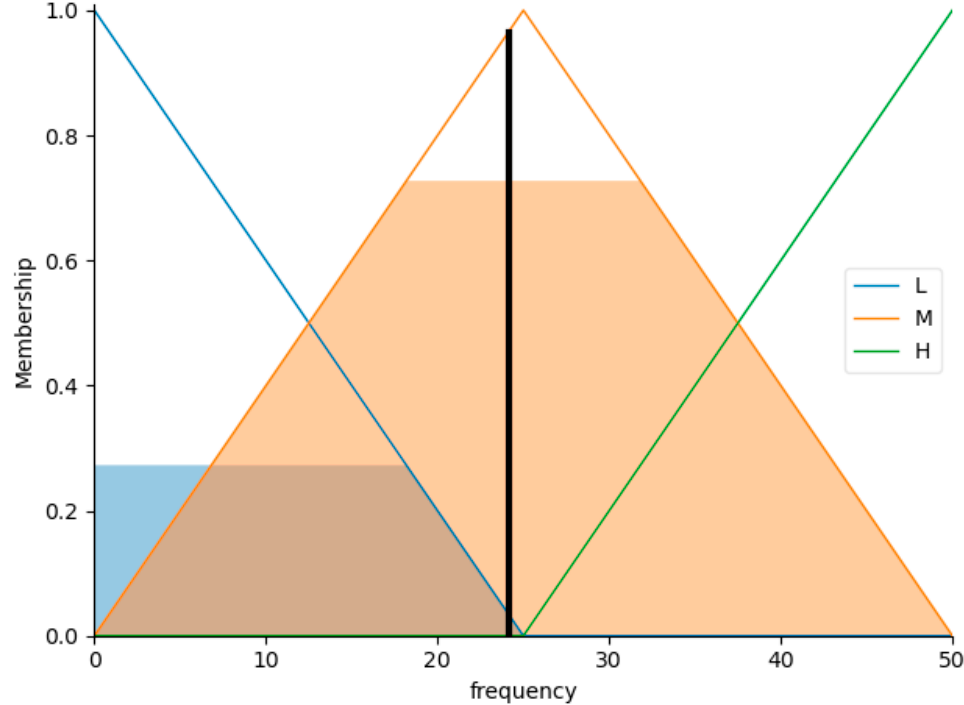
Figure 12. Membership function of motor frequency under simulated production conditions.